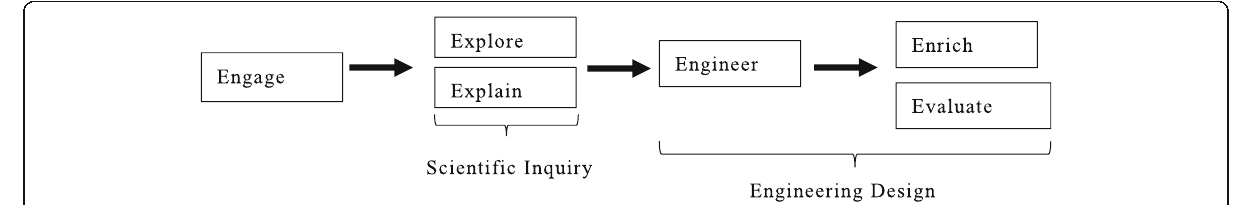
Fig. 1 The 6E Learning byDeSIGN ™ Model simplified by the authors with reference to ITEEA